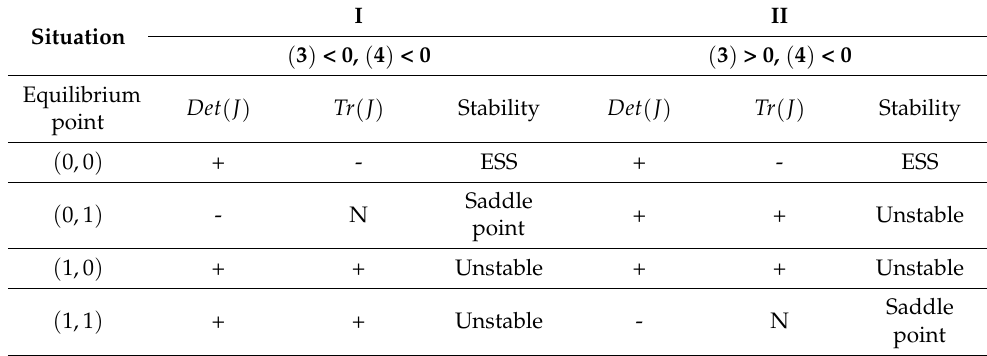
Table 4. Evolutionary equilibrium point analysis for inactive online lending